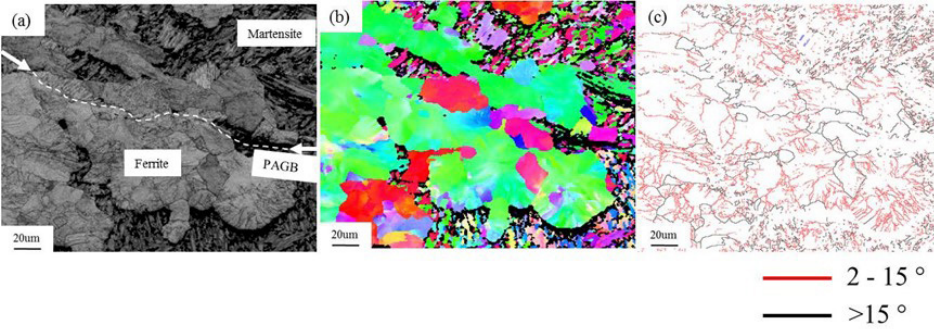
Figure 6. Grain boundary ferrite morphology at 3mm/180s, (a) SEM image, (b) inverse pole figure (IPF), (c) angle